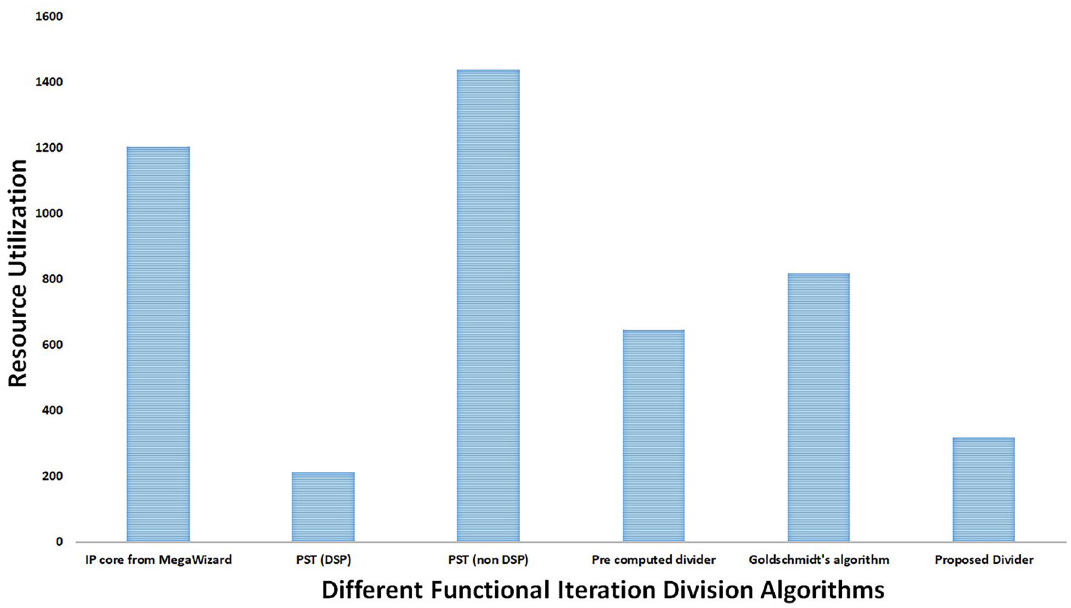
Figure 11. Comparative analysis regarding the hardware resource utilization of the proposed USP-Awadhoot algorithm-based divider and different functional Virtex, Virtex-II, Virtex-II Pro, Virtex-4, Spartan-3, etc. The dividend can be up to 32 bits and has a fully pipe- lined structure. Table 4 compares 8/16/32-bit Xilinx IP core-pipelined dividers and the proposed USP-Awadhoot